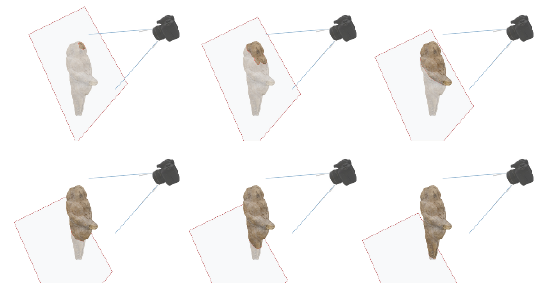
Figure 4. Movement of the focal plane during the acquisition with focus